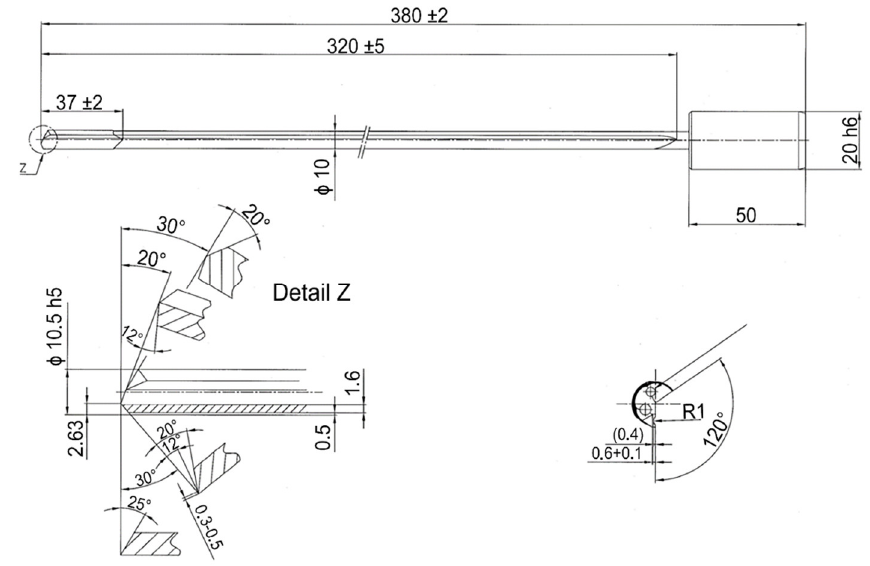
Figure 1. Gun-drill tool used in the experiment.